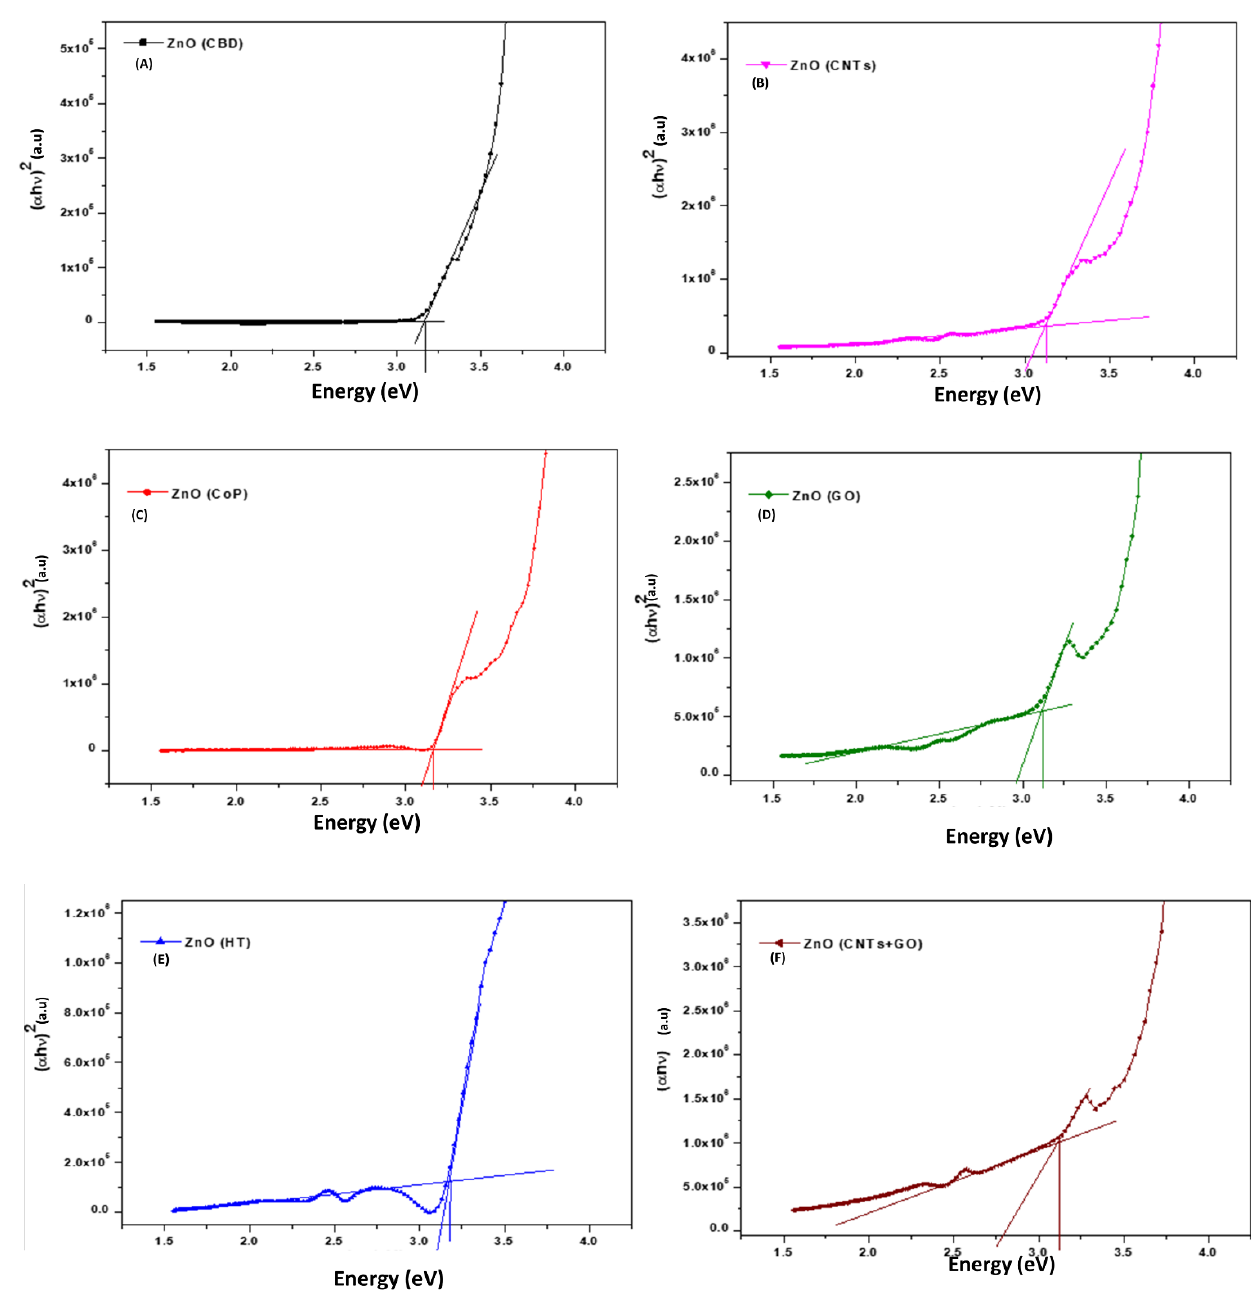
Figure 6. Band gap extraction for the ZnO nanostructures (( A )—CBD, ( B )—CNTs, ( C